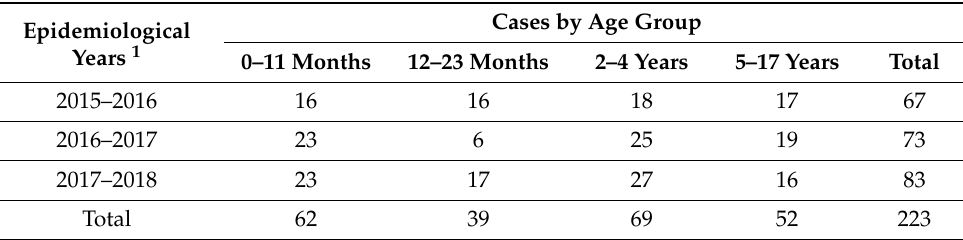
Table 1. Cases of invasive pneumococcal disease from patients <18 years, Portugal, July 2015–June 2018 ( n =